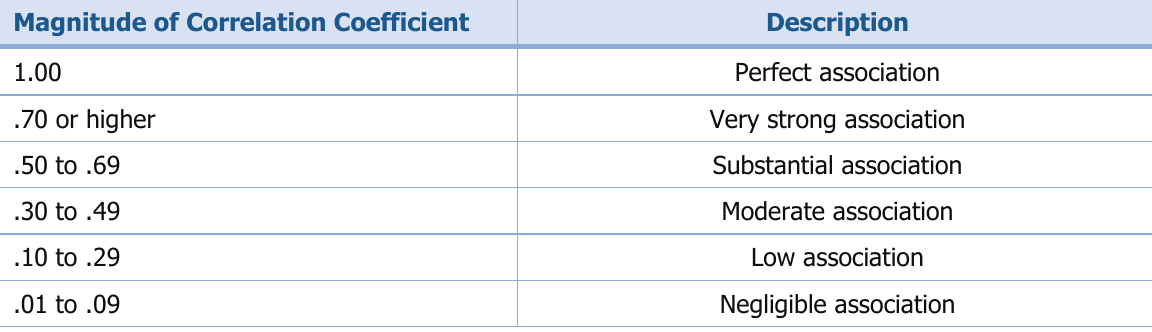
Table 3. Describing the Magnitude of Correlations with Davis’ (1971) Conventions Magnitude of Correlation